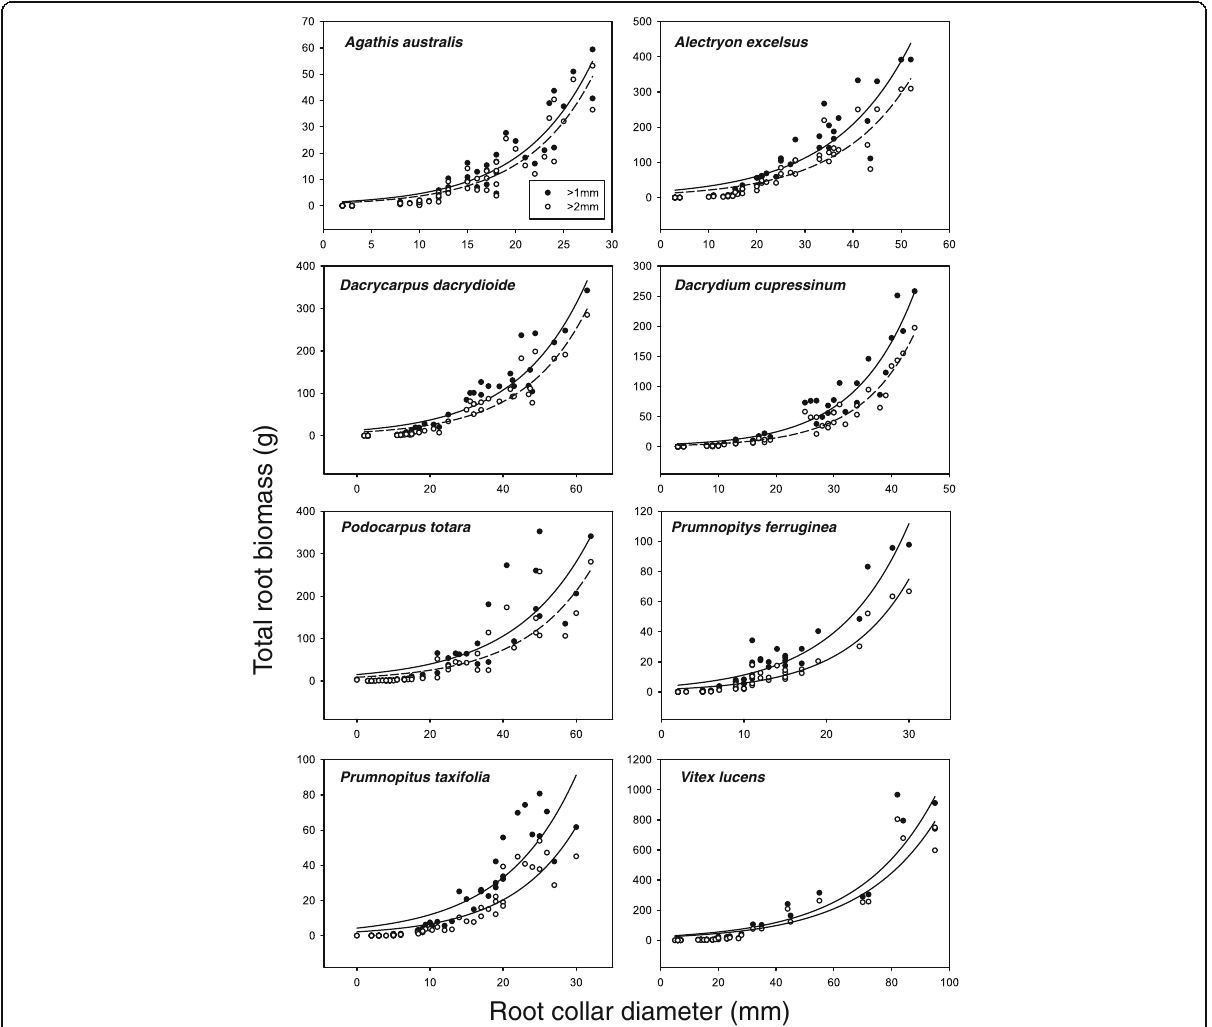
Fig. 8 Exponential growth analysis of RCD and total root biomass. Note that the scale of the y and x axes differs between